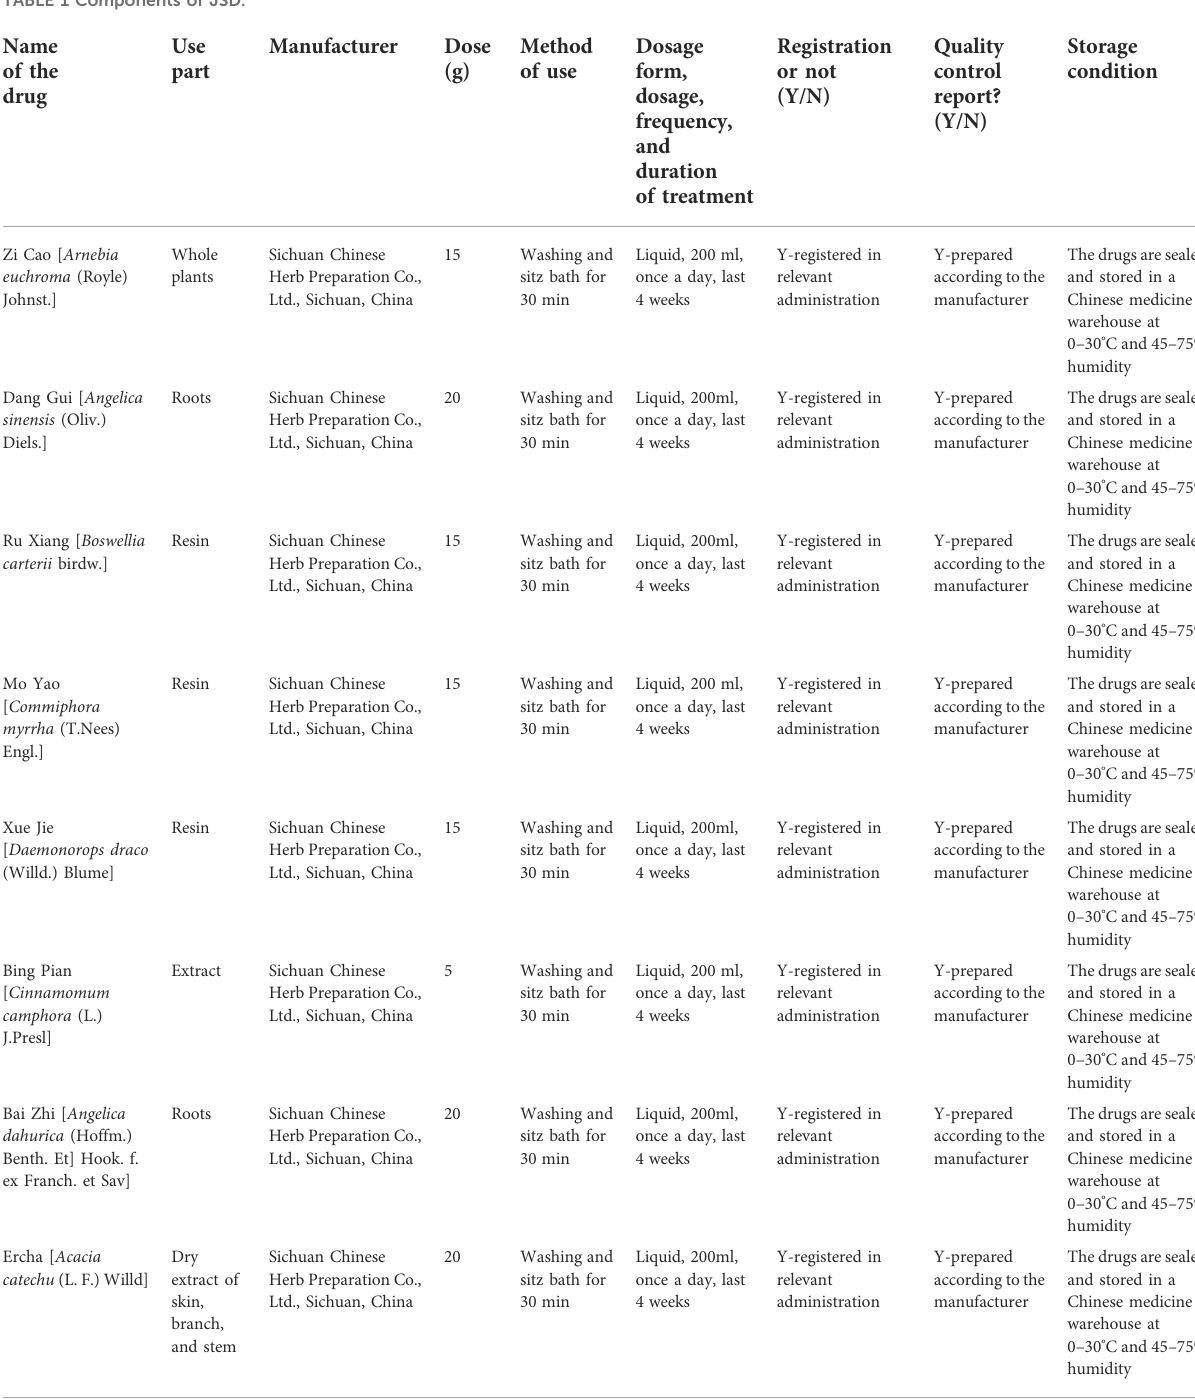
TABLE 1 Components of